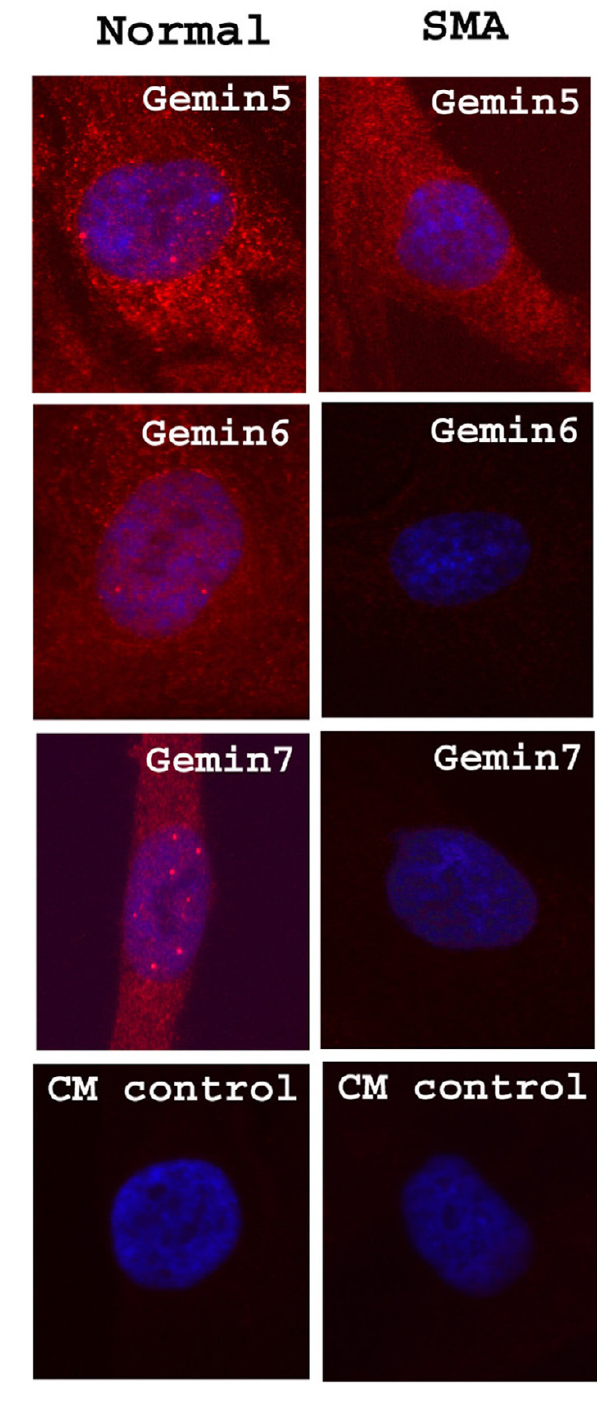
Figure 6 Nuclear gems/CBs and cytoplasmic levels of most gemins are greatly reduced in SMN-deficient human skin fibroblasts, but cytoplasmic gemin5 levels remain high . Alexa fluor 546 goat anti-(mouse IgG) (red) was used to detect SMN and gemin 2, 4, 5, 6 and 7 primary mAbs (the same mAbs as in Fig. 2). TRITC donkey anti-(rabbit Ig) was used to detect anti-gemin3 rabbit antibodies. DAPI (blue) was used to counterstain the